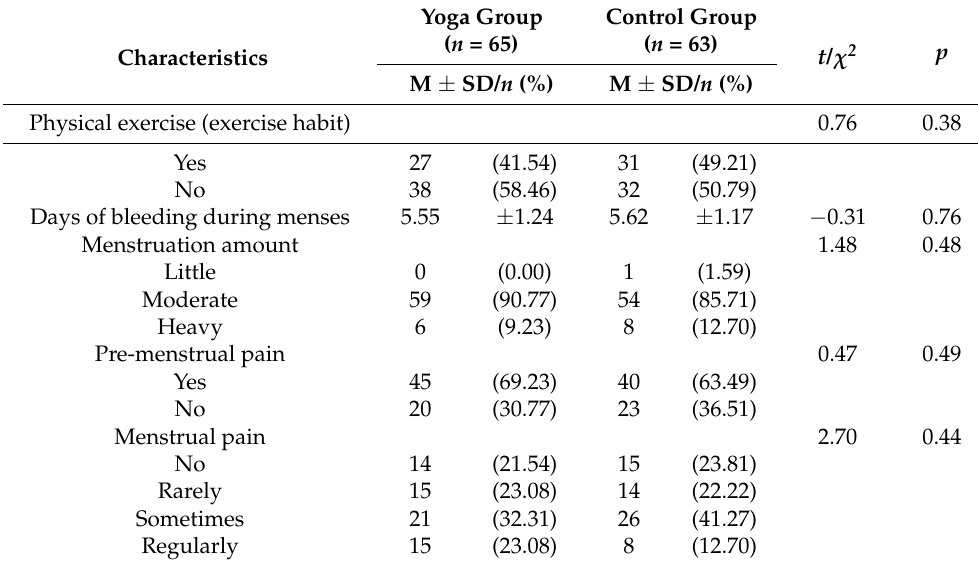
Table 1. Characteristics of the participants in both groups .